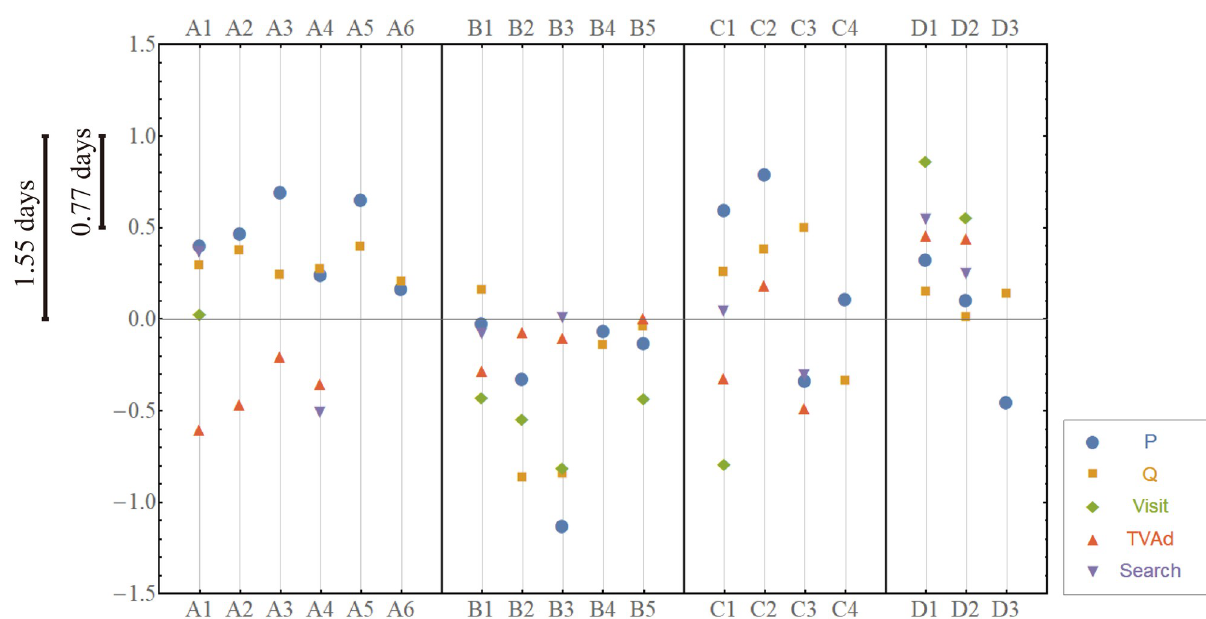
Fig 8. The fundamental sequence of exposures to marketing instruments and purchases for each product. The vertical axis represents the Hodge potential, whose value is larger as it leads than others. Horizontally, products are arrayed in an arbitrary order. If the positions of two time series are closer, they are comoving almost simultaneously with each